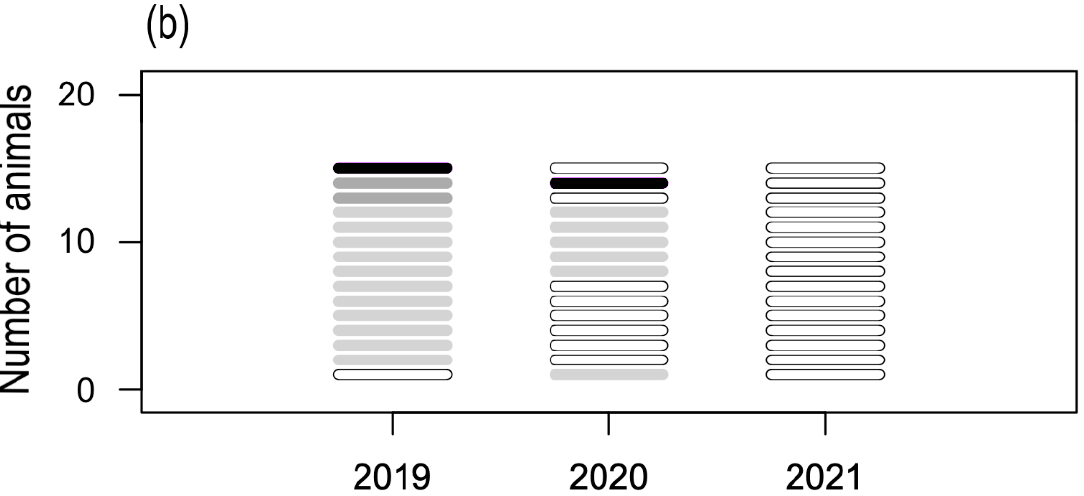
Figure 2. Trend of adverse reactions recorded in the first year of enrollment and monitored during the first ( a ) and the second ( b ) study period. Severity of the reactions is reported in different colors (black: intense; dark gray: moderate; light gray: mild; white: no reaction). Each row represents the same animal tested during the study period.